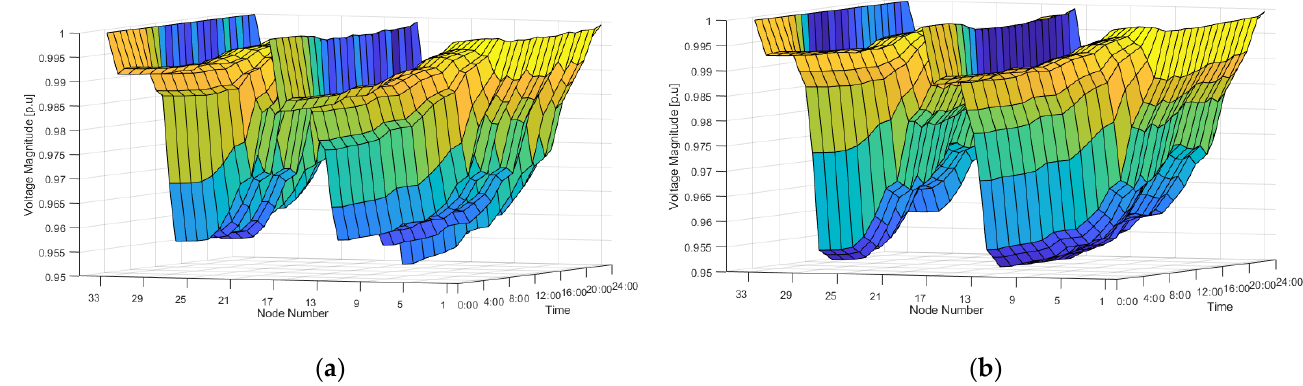
Figure 14. Voltage profiles of the distribution network on ( a ) a winter ’s day and ( b ) a summer ’s